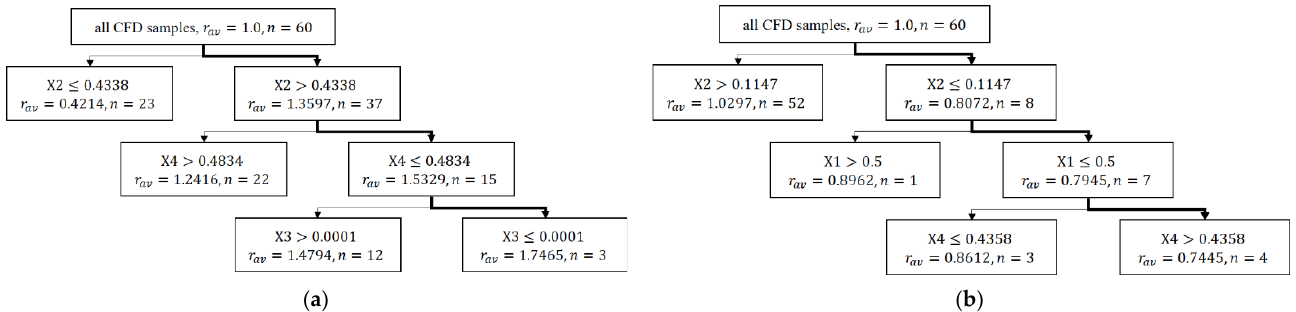
Figure 16. Decision tree analysis : ( a ) Geometric constraint based on the position of the cone center; ( b ) Geometric constraint based on the intersected planes.